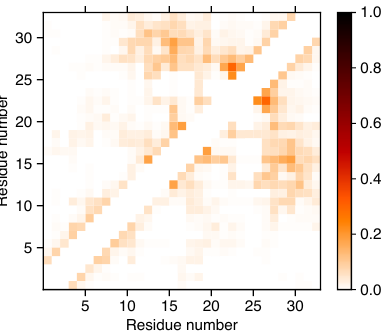
Figure 7. Contact map showing the probability of amino acid residues being closer to each other than cutoff of 4.0Å. Darker colour indicates higher probability, and white corresponds to zero probability. Residue interactions with themselves, as well as two neighbouring residues on each side, were excluded from analysis.